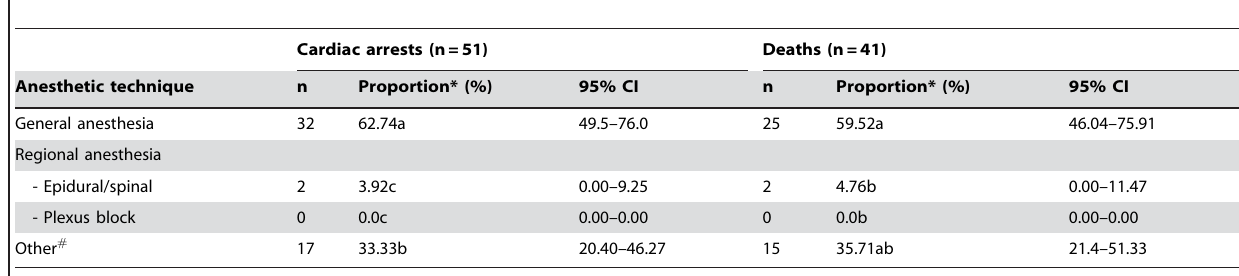
Table 3. Intraoperative cardiac arrest and mortality proportions in trauma patients, grouped by anesthetic